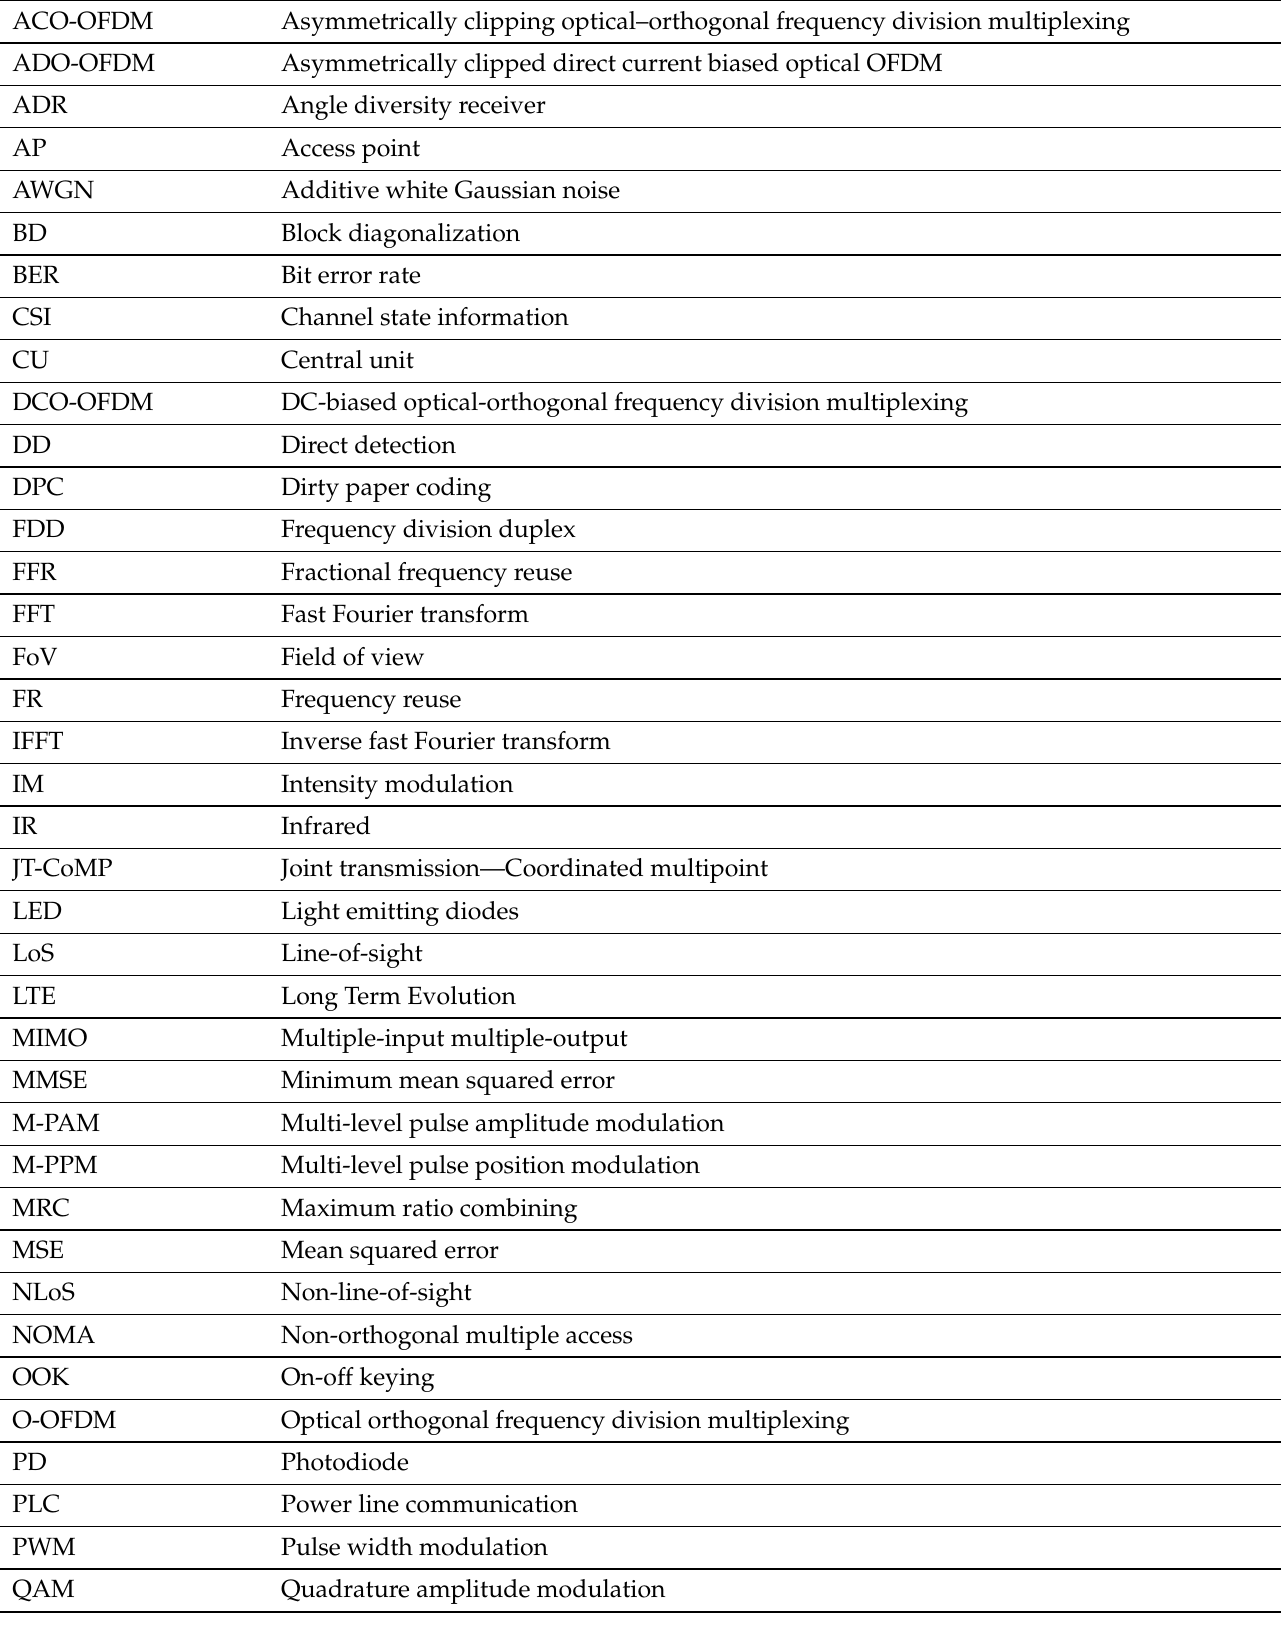
Table 1. List of acronyms in this